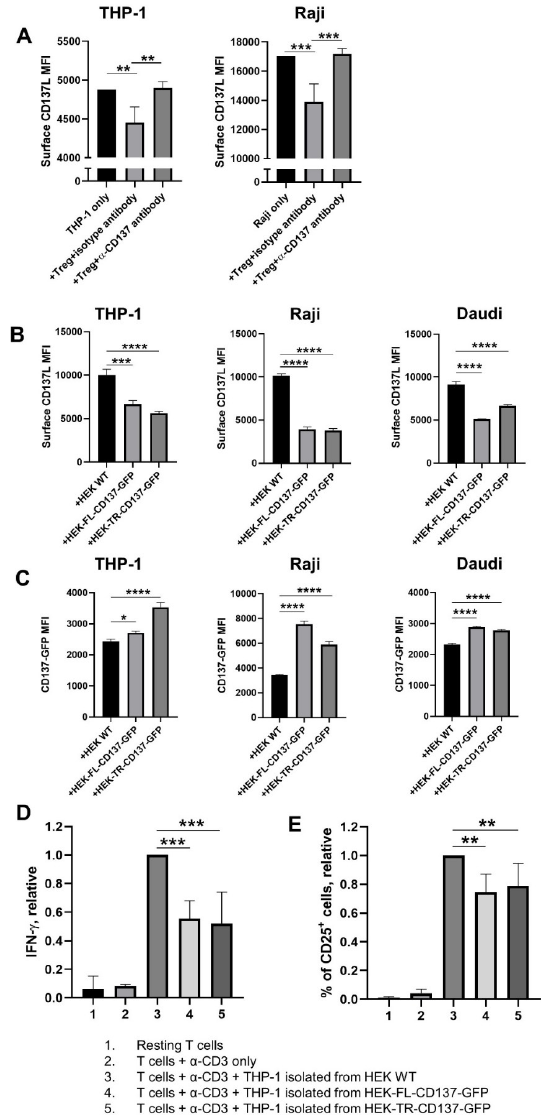
Figure 3. Activated human Treg and CD137-transduced HEK293 (HEK) cells use CD137 to downregulate CD137L on APC cells. ( A ) Treg isolated from human peripheral blood mononuclear cells (PBMC) from healthy donors were activated with 100 ng/mL Phorbol 12-myristate 13-acetate (PMA) and 1 μ g/mL ionomycin for 24 h and washed and cocultured with Carboxyfluorescein-succinimidyl-ester (CFSE)-labelled THP-1 or Raji cells for 1 h at a ratio of 2 Treg: 1 APC, with the addition of 5 µ g/mL of isotype antibody (clone MOPC-21) or anti-CD137 antibody (clone BBK-2). ( B , C ) THP-1, Raji, and Daudi cells after coculture with transduced HEK cells. HEK WT, HEK293 cells expressing green fluorescent protein (GFP)-tagged full-length (HEK-FL-CD137-GFP), or HEK293 cells expressing GFP-tagged truncated CD137 (HEK-TR-CD137-GFP) cells were cocultured with APC for 1 h at a ratio of 10 HEK: 1 APC. ( B ) Surface CD137L levels. ( C ) GFP fluorescence of THP-1, Raji, and Daudi cells after the coculture. ( D , E ) Fixed isolated THP-1 cells were cocultured with isolated CD8 + T cells from PBMC of healthy donors at a ratio of 1 THP-1 cell: 10 CD8 + T cells, for 72 h, in the presence of 0.5 µ g/mL anti-CD3 antibody (clone OKT3). ( D ) IFN- γ level, relative. ( E ) Surface CD25 level, relative. Cells were analysed by flow cytometry for surface CD137L levels after gating for CFSE + cells ( A ), live and single CD45 + cells ( B , C ), or live and single cells ( D , E ). Graphs show means ± SD, * p < 0.05, ** p < 0.01, *** p < 0.001, **** p < 0.0001, one-way ANOVA with Dunnett multiple compari- son test. Data are representative for at least 3 different donors ( A , D , E ) or at least three independent experiments ( B , C